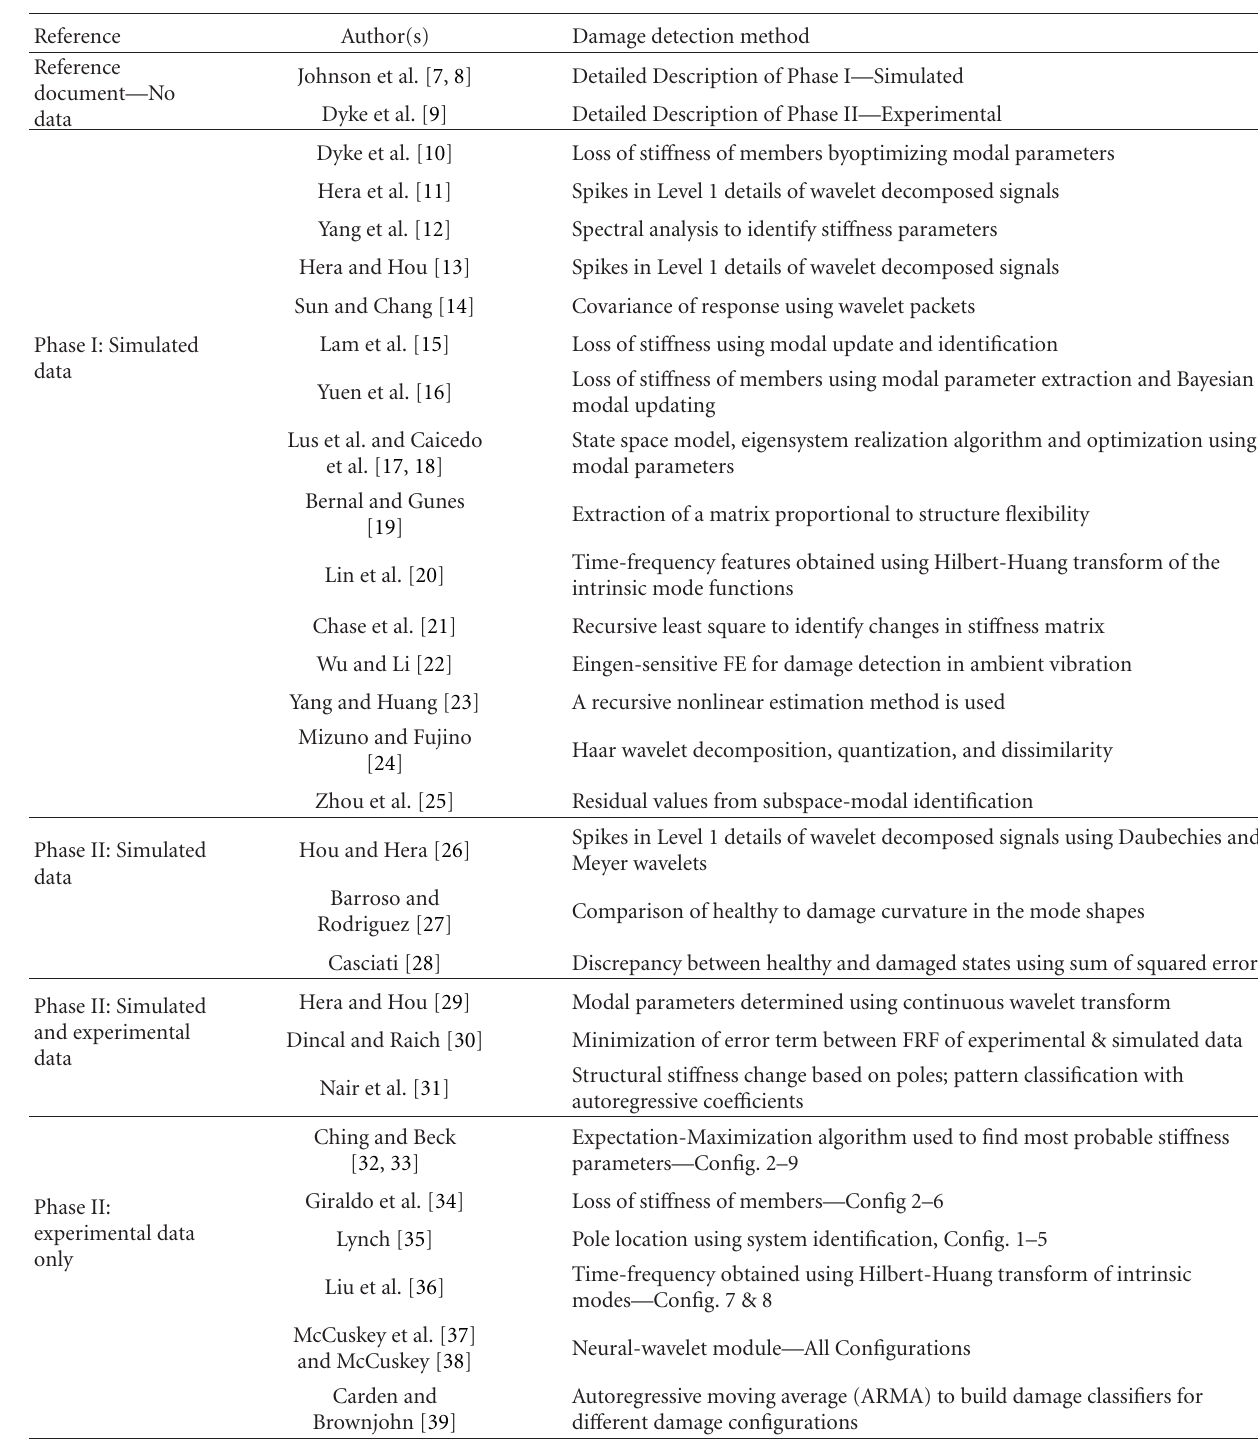
Table 1: Summary of damage detection methods for the ASCE benchmark